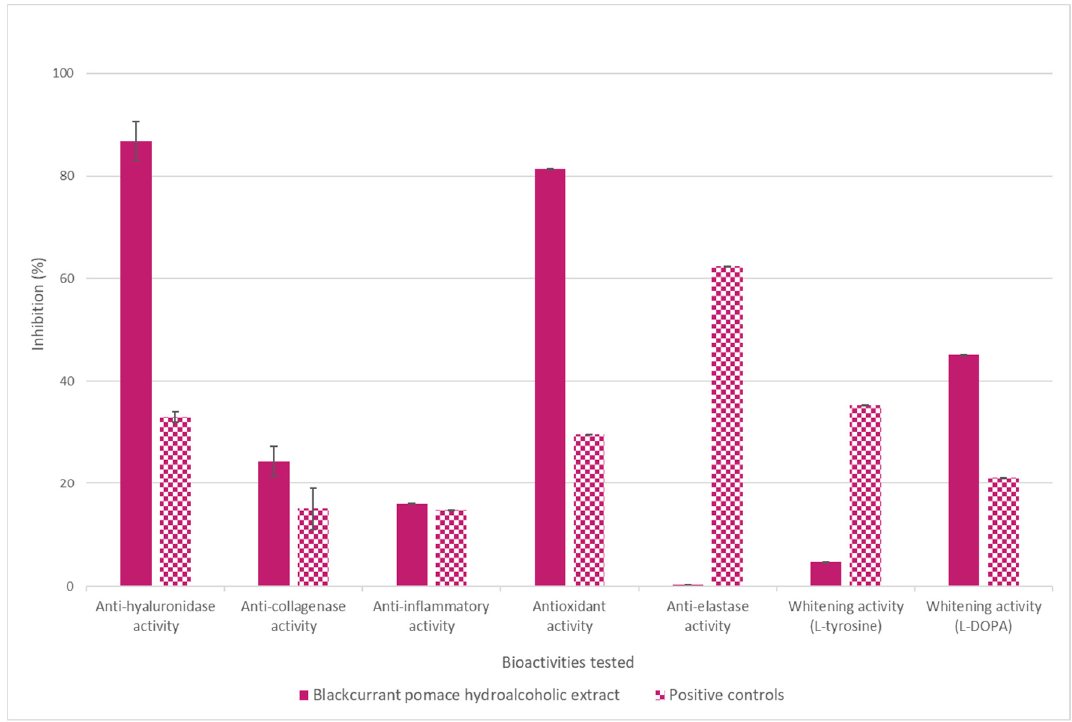
Figure 1. Bioactivities of R. nigrum pomace extract obtained by direct maceration in EtOH/H 2 O 50/50 for 2 h at RT, compared to the bioactivities of the positive controls used for the respective activities tested (positive controls).